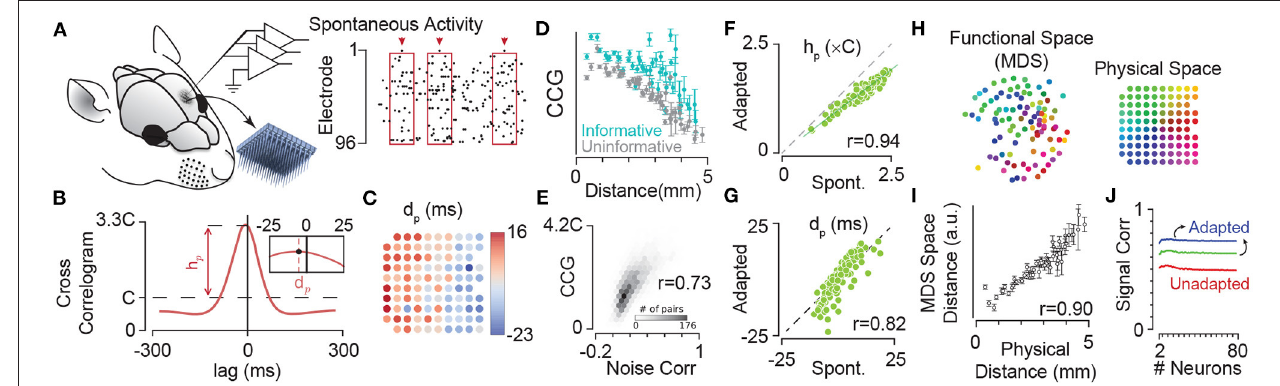
FIGURE 5 | Adaptation maintains dynamics of synchrony in cortical neuronal populations. (A) Extracellular multi-electrode array recording in rat somatosensory cortex using a 10 × 10 array. The inset depicts the 10 × 10 array with 400 µm electrode spacing. (B) The probability density function (PDF) of the population activity triggered by spikes on an example electrode (arrows in A ). This is identical to the cross-correlogram analysis. The peak of this PDF relative to chance level (denoted by C ), represented by h p , quantifies the synchrony between each electrode and the pooled activity. The inset depicts the median of the PDF, denoted by d p , which estimates the delay (or lead) of each electrode relative to the population spiking at all other electrodes. (C) Map of electrodes colour coded by their corresponding d p values. The d p changes systematically from positive (leading the population) to negative (lagged relative to the population) most evident along the rows corresponded to the medio-lateral stereotaxic axis. (D) The mean and s.e.m. of strength of correlations (CCG) in spontaneous activity for informative pairs of units (where both electrodes in a pair were informative about sensory stimuli; cyan) and uninformative pairs (where both electrodes had low information about sensory stimuli; grey). Pairwise CCGs were calculated similar to that in (B) , but across two electrodes. (E) The histogram of correlations in spontaneous activity (normalised to the chance level C) against spike-count correlations in the fluctuations of evoked neuronal activity (noise correlations) showing significant strong relation between them. (F) Adaptation maintains the structure of correlations across the network. Strength of coupling in the spontaneous activity (non-adapted state, the abscissa) is highly correlated (correlation coefficient, r = 0.94) with those during sustained sensory stimulation (adapted condition, the ordinate). Each circle corresponds to an electrode. (G) Same as in (F) , but for d p . The values of d p for episodes of spontaneous activity were highly correlated with those for the sustained stimulation ( r = 0.82). This indicated that the sequence of activation among electrodes is highly preserved across the spontaneous (non-adapted) and adapted conditions. (H) The position of electrodes in the functional space built based on the pairwise CCG values from (D) . The functional space is reduced to two dimensions with multi-dimensional scaling (MDS). Colours of electrodes were assigned based on their spatial position as shown in the inset array. The spatial structure of coupling across neuronal population predicts the physical position of electrodes. (I) The mean and s.e.m. of distances in the 2-dimensional functional space at each physical distance. For dimensions higher than two, changes in the relation of functional space and anatomical space remained relatively small (less than 5%). (J) Adaptation increases signal correlations—correlations across response functions across stimuli—in neuronal populations. Signal correlation as a function of population size under the three adaptation states as in Figure 3 . Colour convention is identical to Figure 3 . Modified from Adibi et al. (2014) and Sabri et al.